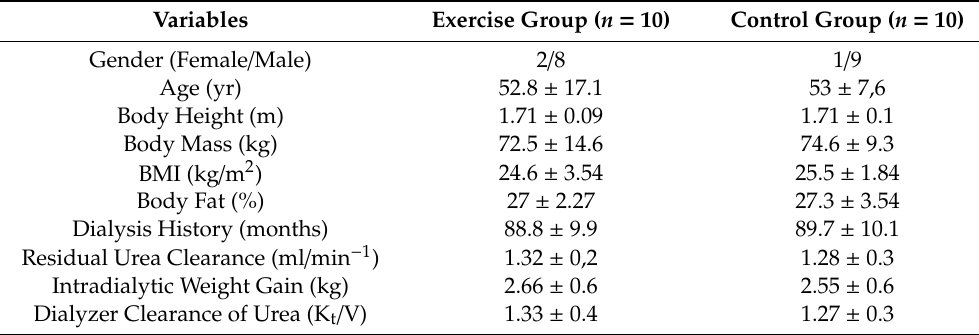
Table 1. Participants’ physical and clinical characteristics at